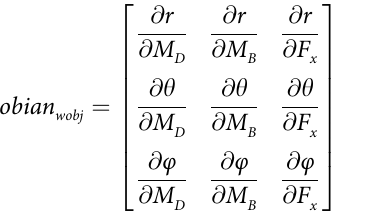
Fig 4. The 3D contact point (r wobj , θ wobj , φ wobj ) can be determined from F x , M B , M D during active whisking. The data in this figure exclude small angle deflections, i.e., any point that lay less than s closest � tan(2˚) from the whisker, where s closest is the arc length of the point on the whisker closest to the contact point. (A) Top and front views from the raw video data of a rat whisking forward into the back of the peg (left two images) and backwards into the front of the peg (right two images). The tracked whisker is traced in red. (B) The F x , M B , and M D data output by the model as the rat whisked into the peg. Note the sudden change in M D when the rat switches from whisking forward to whisking backward into the peg. (C) F x , M B , and M D from B plotted onto the mapping visualizations for r wobj , θ wobj , and φ wobj . These visualizations show the relevant parts of the mappings from Fig 3D, and the monochromatic layers are plotted as translucent for better visualization. The black dots represent the data from B plotted onto F x , M B , M D space. The color , φ . of the “solid” at the black dots in each of the three plots gives the contact point location coordinates: r wobj , θ wobj wobj (D) The r wobj , θ wobj , and φ wobj values given by the mappings in C (E) Tracked values of r wobj , θ wobj , and φ wobj plotted against the values of r wobj , θ wobj , and φ wobj as predicted from the mechanical signals. The dots are translucent to improve visualization. The black diagonal line represents where the dots would lie if the 3D contact points computed from the mechanical signals were perfect. In Fig 4C, the color of each of the solid objects at the location of the black points yields the reading for the estimated contact point location. Using the appropriate look-up table for this mapping, we can obtain predicted values for the contact point (r , θ , φ ) which are wobj wobj wobj plotted as functions of time in Fig 4D. The quality of the predicted values for (r , θ , φ ) was evaluated by plotting them wobj wobj wobj against the ground-truth tracked values for (r , θ , φ ); results are shown in Fig 4E. wobj wobj wobj Data points for each measurement at 1 msec intervals are represented by a black dot. If they fall on the black diagonal line, the predicted value exactly matches the tracked value. The fact that the points generally lie close to the diagonal line shows the high quality of the mapping between mechanical signals and the 3D contact point. As expected, predictions from the look-up table show the greatest errors for the variable r . These errors result from limitations in the resolution of the mappings for small deflec- wobj tions: very small changes in force can cause large jumps in predictions for r . wobj